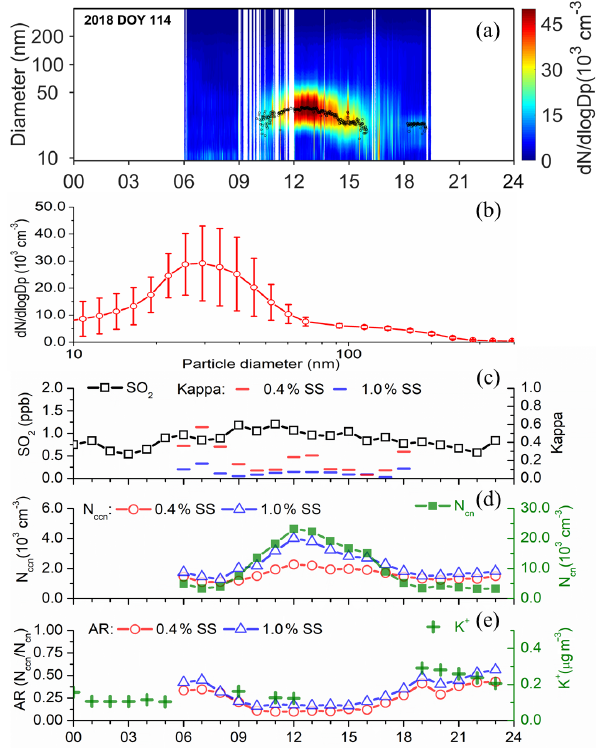
Figure 6. (a) Contour plot of particle number size distributions for the DOY 114 2018; (b) the size distributions of the particle number concentration during 10:00–18:00LT DOY 114, 2018; (c) time se- ries of hourly averaged SO 2 and Kappa values at SS of 0.4% and 1.0%; (d) N ccn at SS of 0.4% and 1.0%; and (e) AR values at SS of 0.4% and 1.0% and K + for DOY 114, 2018.